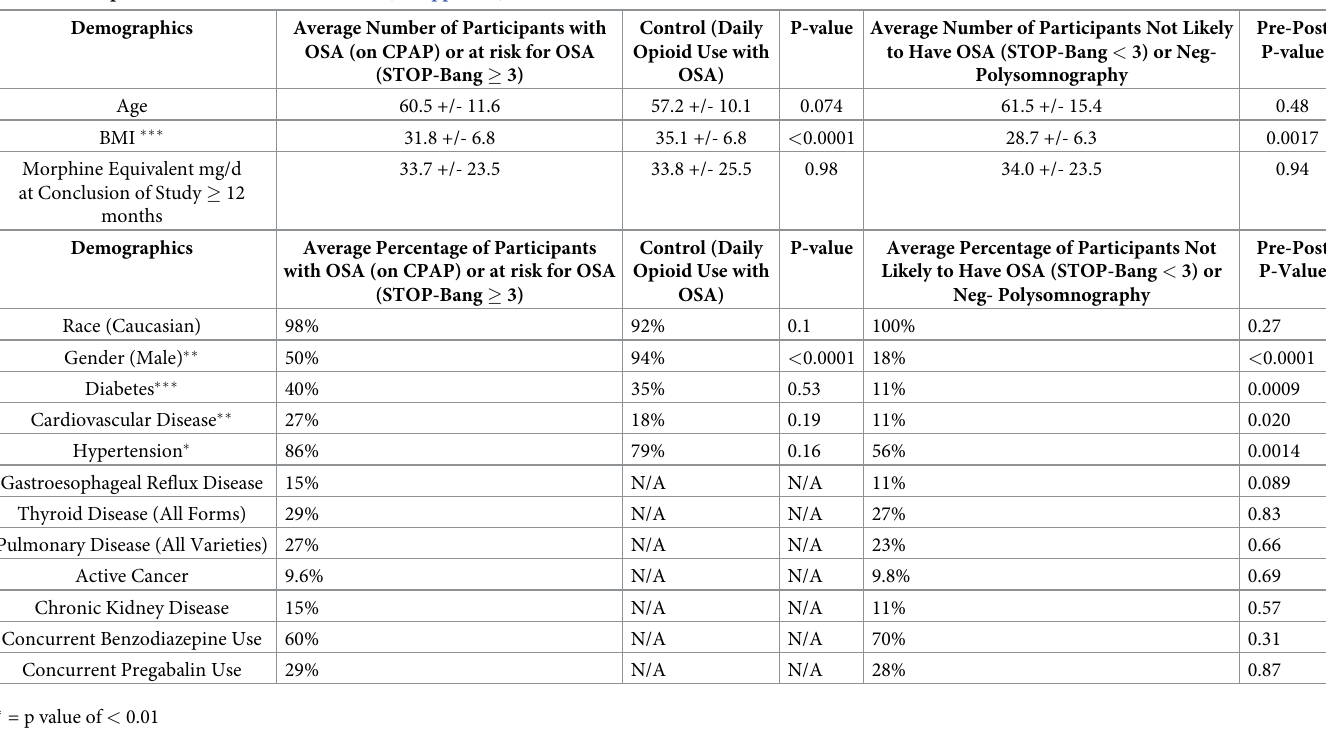
Table 1. Comparison of clinical characteristics (S1